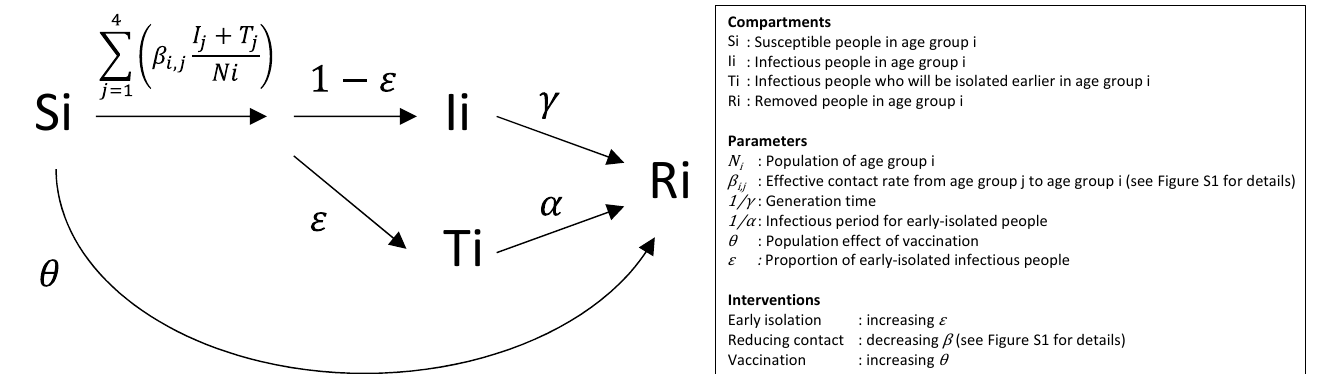
Figure 1. Scheme of the simulation model. The figure depicts the compartment model developed for the simulation in this study.